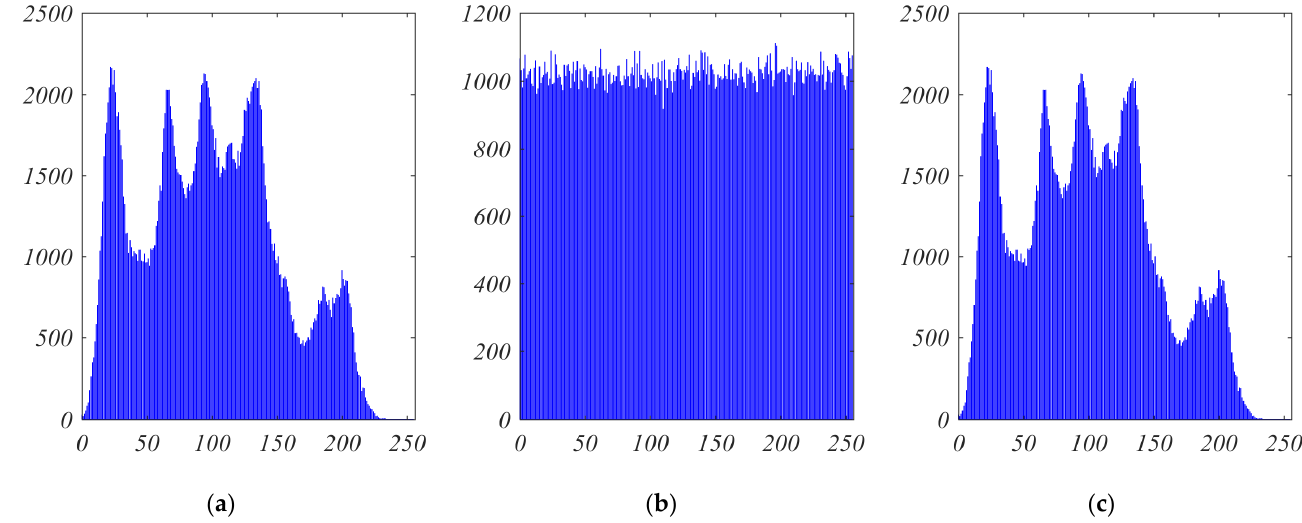
Figure 18. The histogram: ( a ) the original image histogram; ( b ) encrypted image histogram; ( c ) the decrypted image his- togram.